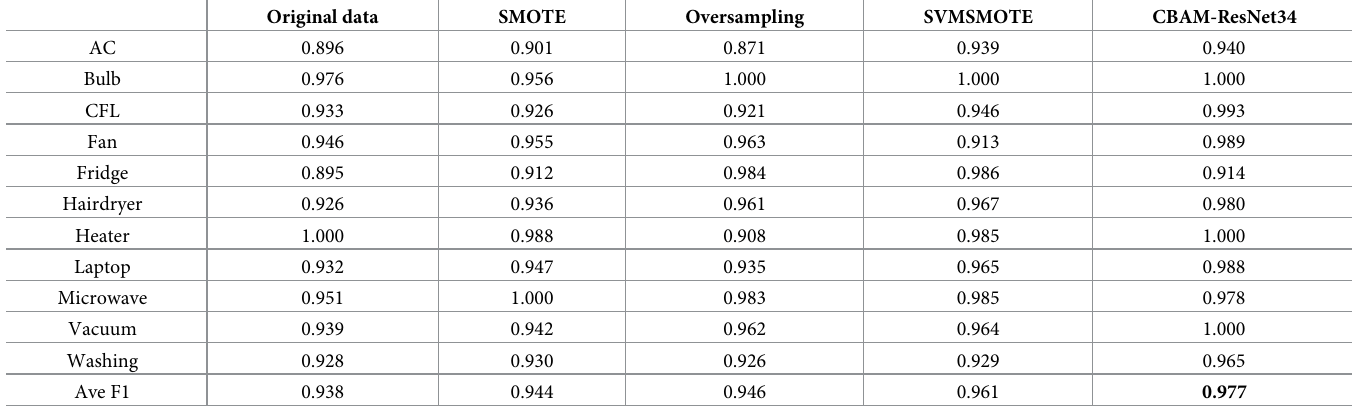
Table 3. The F1 for different data balance algorithms using transferred